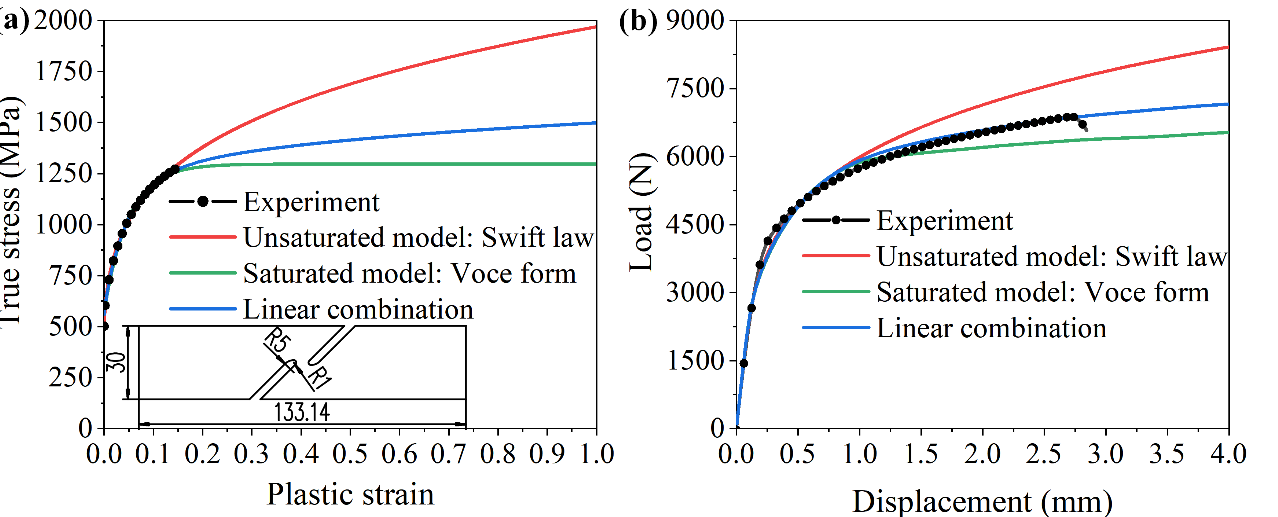
Figure 5. ( a ) True stress–true plastic strain curves. ( b ) Load–displacement curves.